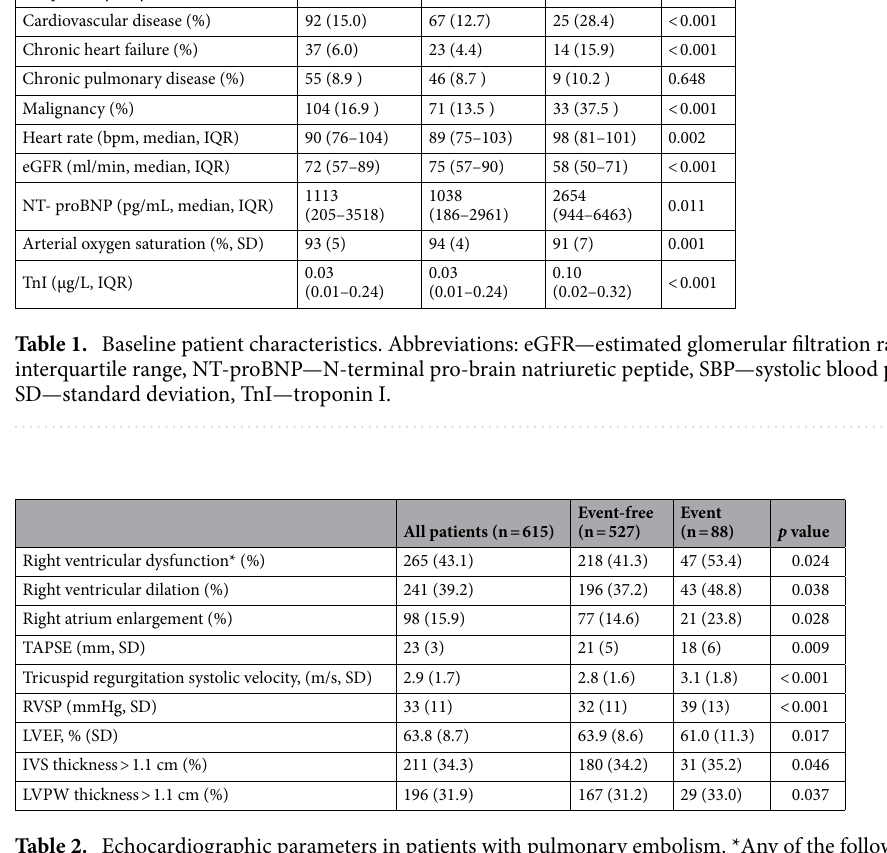
Table 2. Echocardiographic parameters in patients with pulmonary embolism. *Any of the following: RV dilation, TAPSE < 18 mm or tricuspid regurgitation systolic velocity ≥ 2.7 m/s. Abbreviations: IVS— interventricular septum, LVEF—left ventricular ejection fraction, LVPW—left ventricular posterior wall, RVSP—right ventricular systolic pressure, SD—standard deviation, TAPSE—tricuspid annular plane systolic